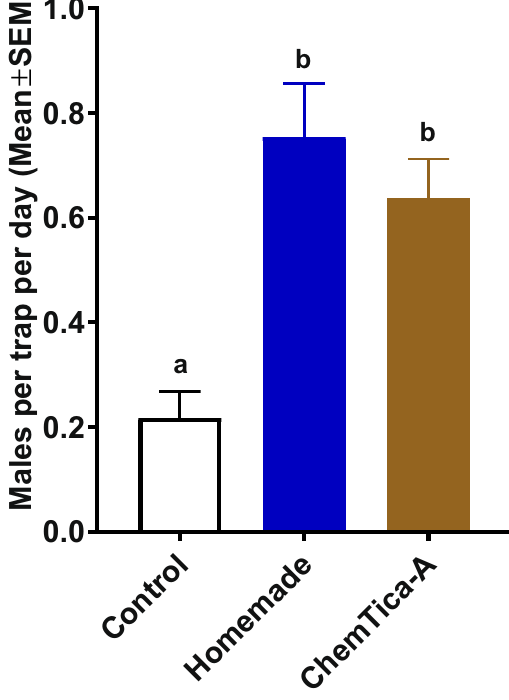
Figure 7. Comparison of a newly developed slow-release formulation (ChemTica-A) with a homemade formulation that required daily renewal. Despite ACP low density in the tested area, traps baited with slow- release and homemade formulations captured significantly more ACP males than control traps. Data were analyzed by Kruskal-Wallis, followed by Dunn’s multiple comparison tests. Bars labeled with the same letter represent treatments that are not significantly